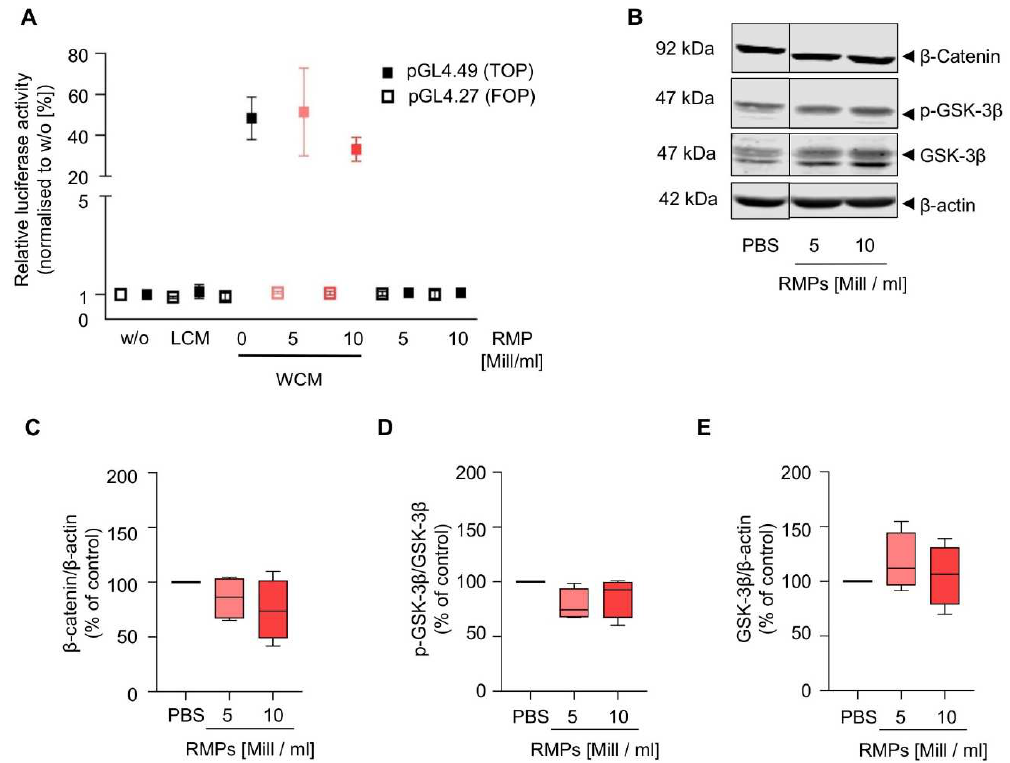
Figure 5. Influence of red blood cell-derived microparticles on the Wnt signaling pathway in HEK293T and HCT-116 cells. ( A ) Wnt reportergene assay. 24 h after co-transfection with either pGL4.27 (TOP) or pGL4.49 (FOP; negative control) with pGL4.74 (Renilla plasmid, transfection control), HEK293T cells were incubated with L-cell conditioned medium (LCM; negative control), Wnt-3A conditioned medium (WCM; containing active Wnt-3A protein), or WCM + one of two concentrations of red blood cell-derived microparticles (RMPs; 5 × 10 6 or 10 × 10 6 particles/mL). After 24 h, the Wnt system. Data represents median plus SD after normalization to renilla activity and untreated